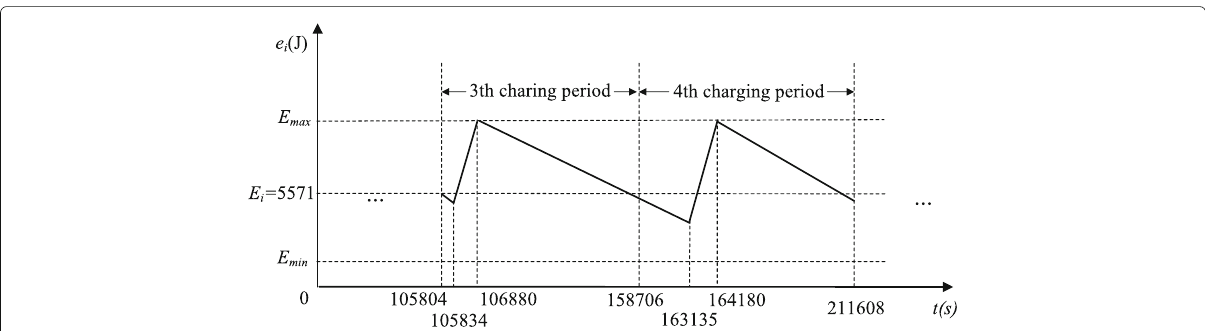
Fig. 6 Data routing for proposed ERSVC in the 100-node network. Similar to Fig. 3, this figure illustrates the data routing result for the 100-node network